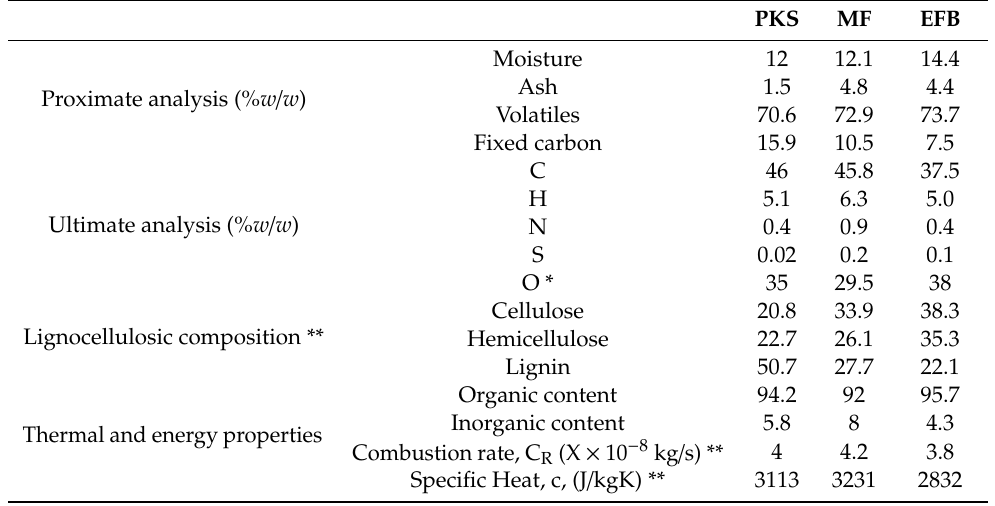
Table 3. Biochemical analysis of individual palm waste biomass.